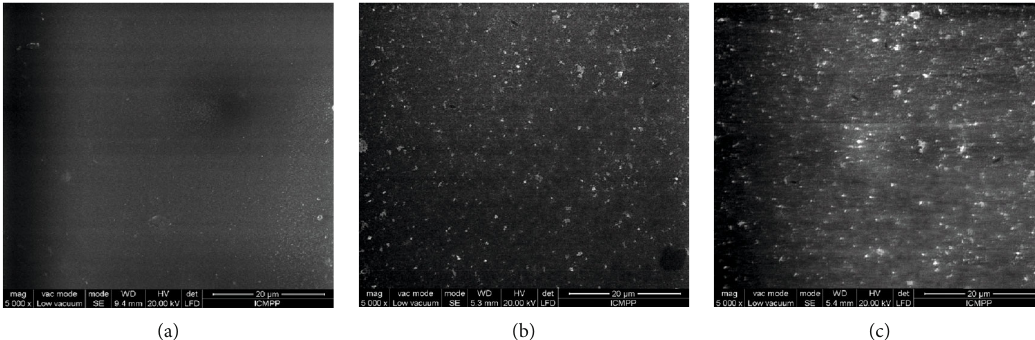
Figure 2: SEM of images of PET (a) untreated and anchoring the Au particles after plasma action for (b) 3min and (c) 5min.